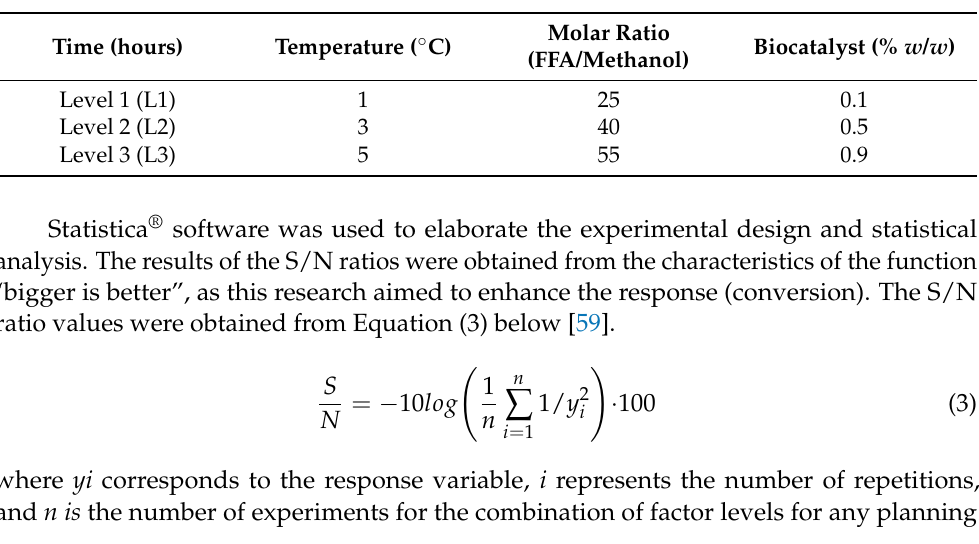
Table 6. Independent factors and their corresponding levels for the optimization of biodiesel